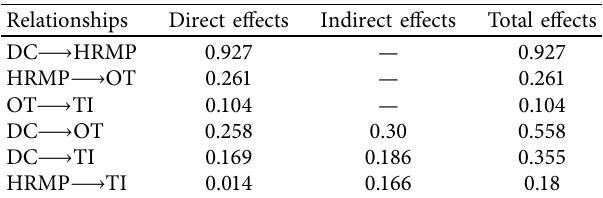
Figure 1: Conceptual model of research. Table 1: Separation of total, direct, and indirect